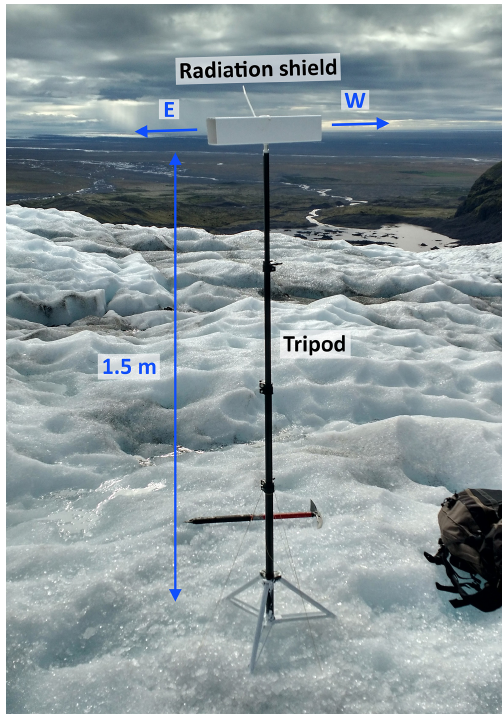
Figure B2. Example of Gemini TinyTag housing used for measur- ing on-ice temperature at one location.